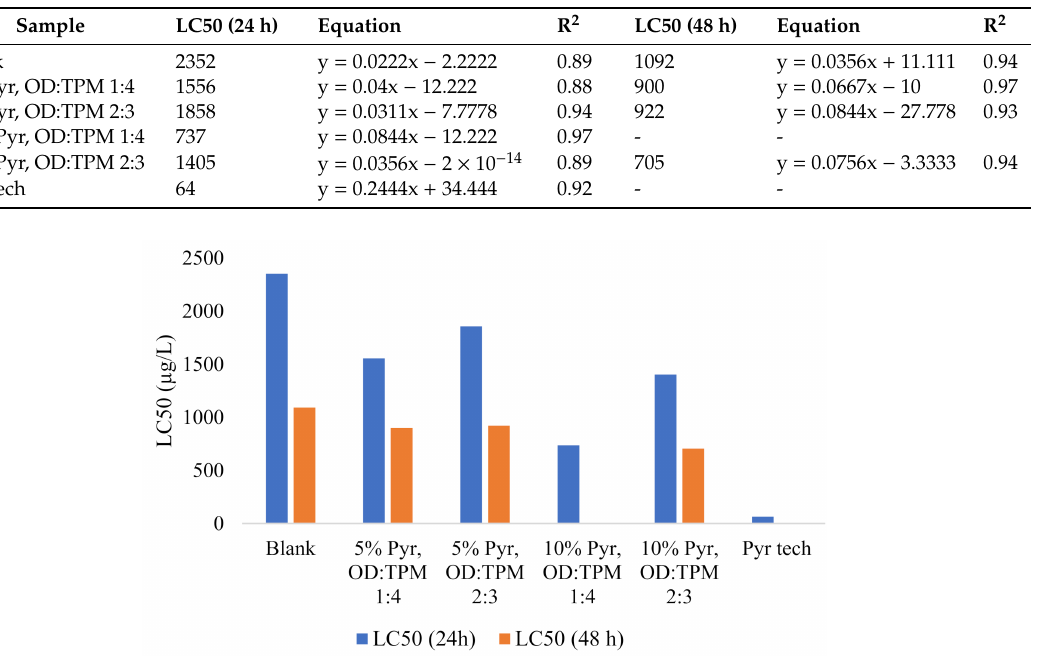
Table 5. Median lethal concentration (LC50) values of PyrSMCs with various compositions on Artemia salina .